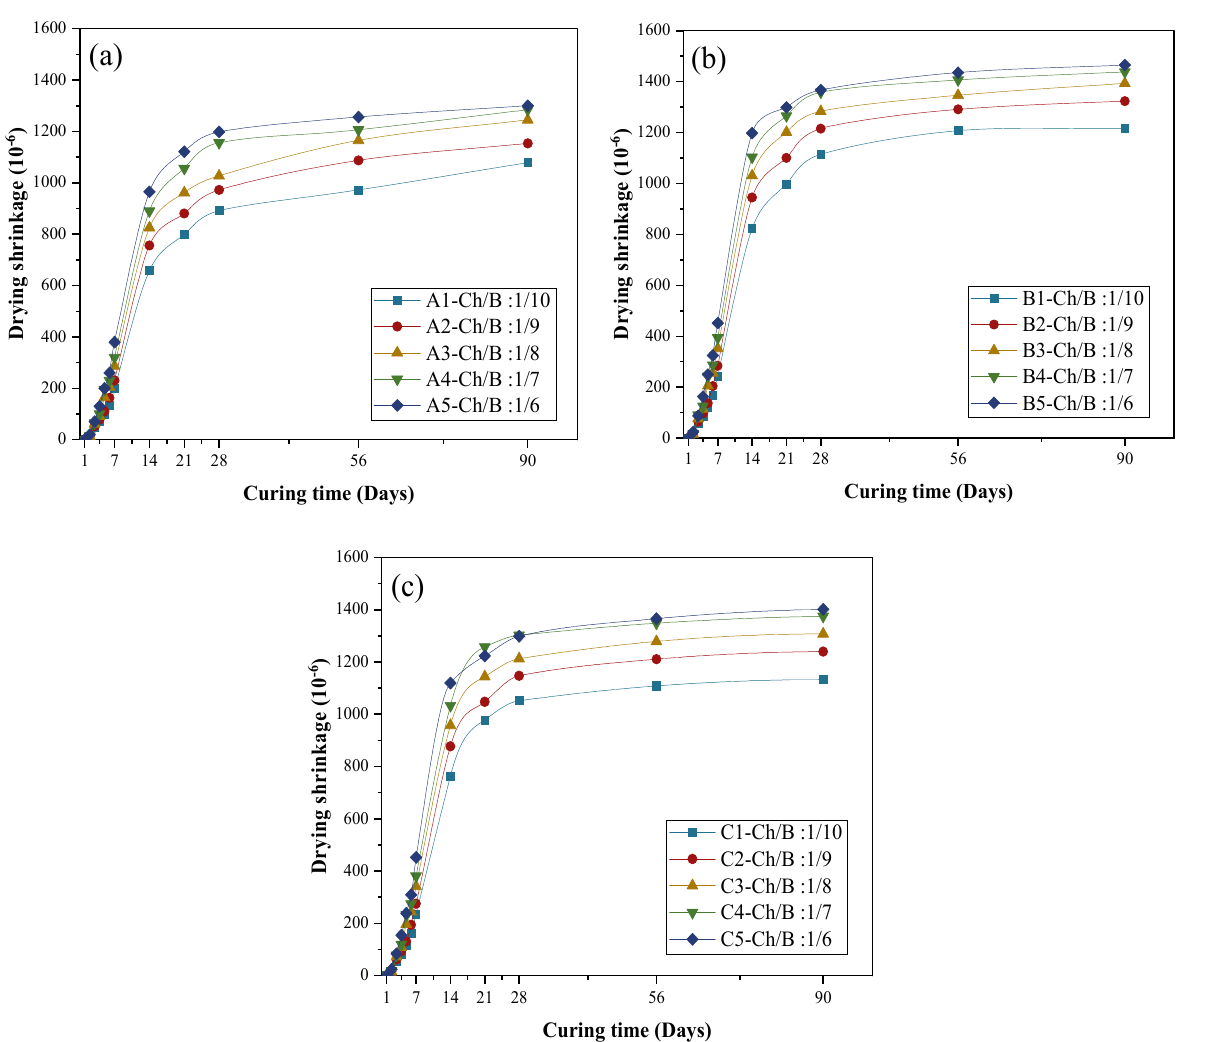
Figure 10. Drying shrinkage in the different groups: ( a ) drying shrinkage of the SAC specimen; ( b ) drying shrinkage of the OPC specimen; ( c ) drying shrinkage of the GBFS specimen.